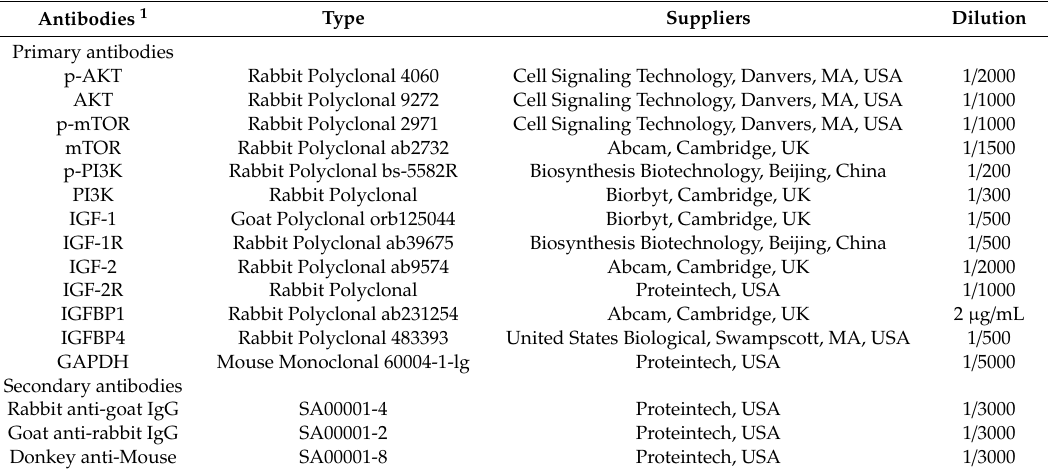
Table 3. The details of antibodies used for Western